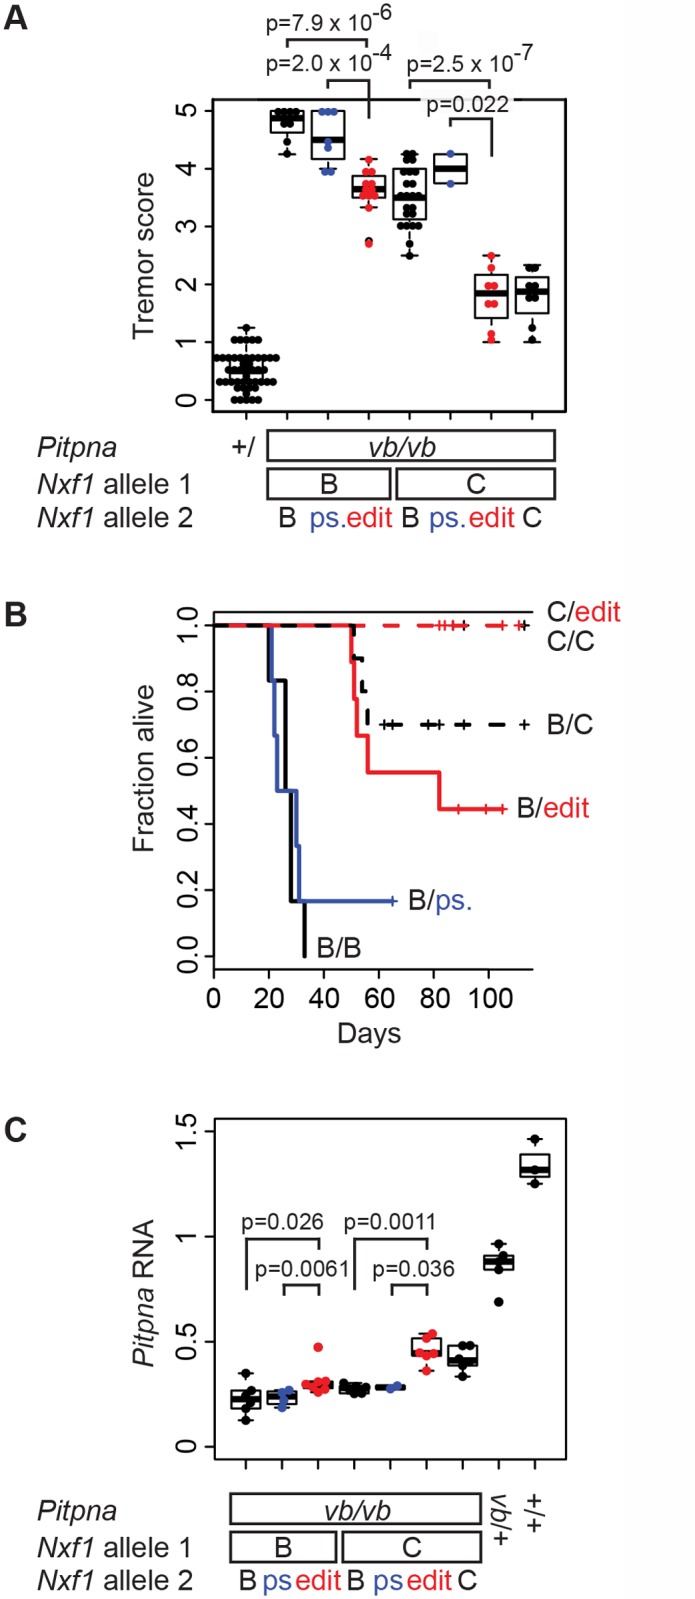
E610G variant accounts for Modifier-of-vibrator activity of Nxf1.
(A) The E610G edited allele decreased tremor severity. Tremor scores for vibrator mutant and littermate control animals of the indicated genotypes are plotted. Each point represents the mean observer score for one animal. P-values for the single hypothesis tests that one copy of the edited allele significantly reduced tremor relative to the unedited or pseudo-edited (ps.) B6 allele are shown. (B) The E610G edited allele increased genotype-dependent survival of vibrator animals. Kaplan-Meier plots show fraction alive over a ~3-month observation period. Heterozygotes for edited alleles are drawn in red, pseudo edited in blue. Censored animals are indicated with vertical lines. (C) Brain Pitpna gene expression from vibrator mutant alleles was increased by E610G alleles. Measurements were made from animals in (A) not used in (B). Relative quantities compared to three reference genes (Gapdh, Sdha, and Ppia) are plotted. Individual points represent the average of three replicate measurements per biological sample.